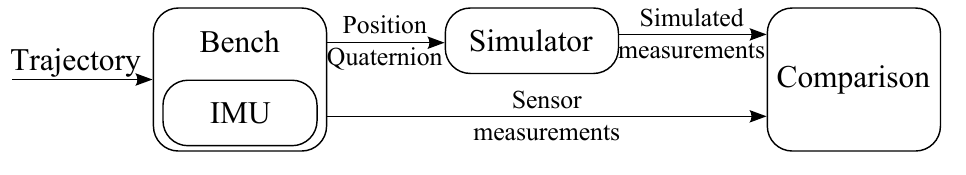
Figure 4. Simulator validation